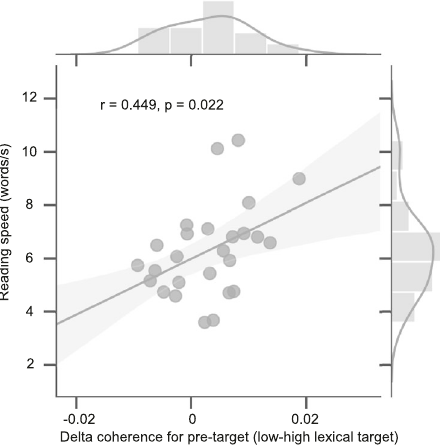
Fig. 5 Relation between lexical parafoveal processing difference and individual reading speed. The coherence-difference with respect to target lexical frequency during fi xations on pre-target words were derived per participant (see Fig. 4b). The reading speed was quanti fi ed as the number of words read per second. Each dot represents a participant. A Spearman correlation demonstrated a signi fi cant relation ( n = 26, two-sided). The solid gray line represents the linear regression fi t with a 95% con fi dence interval (shaded area). Histograms of individual reading speed and pre- target coherence differences are shown on the top and to the right. Source data are provided as a Source Data fi